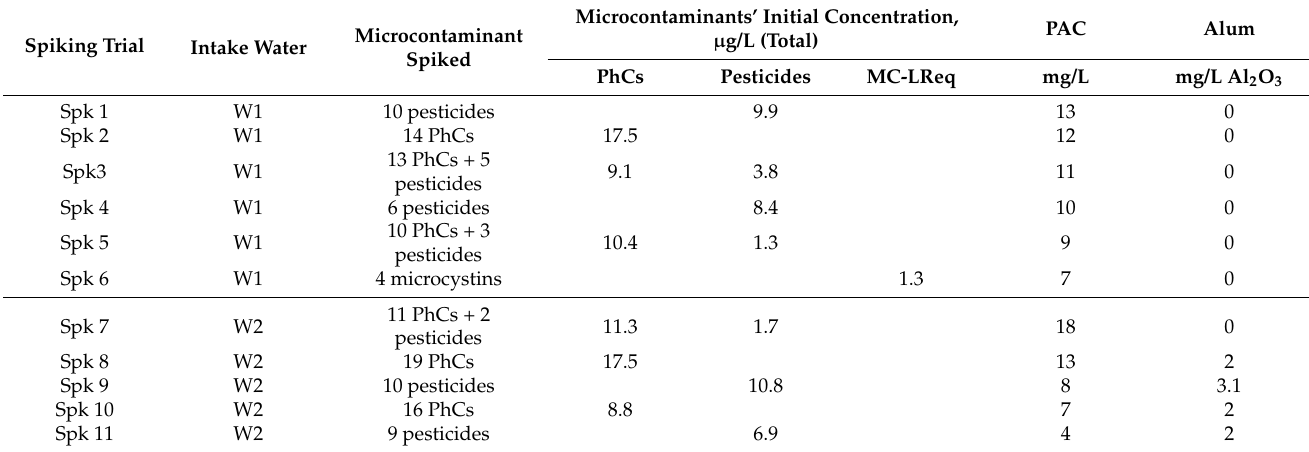
Table 2. Summary of the eleven spiking trials conducted in PAC/(Alum)/MF pilot. Microcontaminants’ Initial Concentration, µ g/L Spiking Trial Intake Water Microcontaminant Spiked